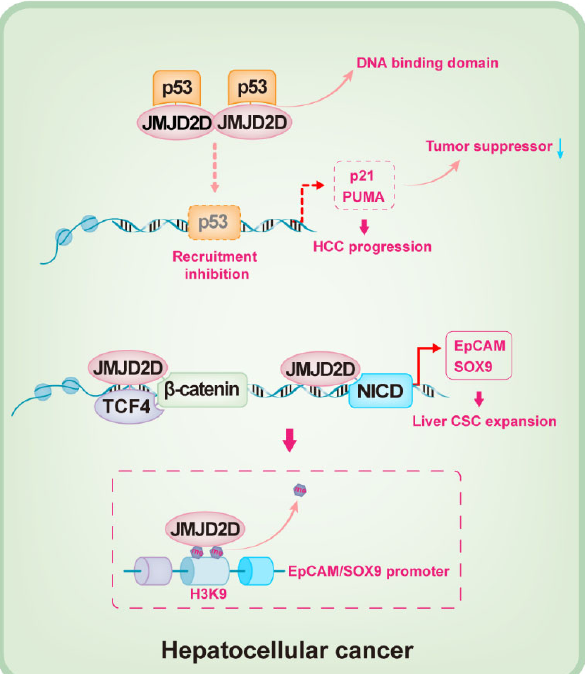
Figure 4. Schematic mechanisms by which JMJD2D promotes HCC progression. JMJD2D promotes HCC initiation and progression by directly binding to the DNA binding domain of p53 to inhibit the recruitment of p53 to the promoters of p21 and PUMA, resulting in the reduction of p21 and PUMA expression. JMJD2D promotes the self-renewal of LCSCs by cooperating with β -catenin/TCF4 and NICD to enhance the transcription of EpCAM and SOX9,